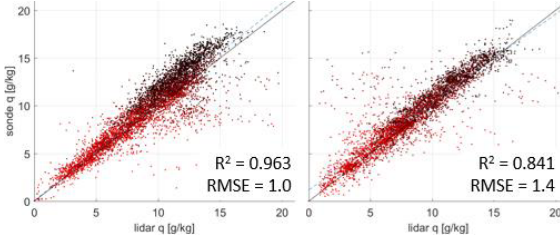
Figure 1. Comparison of water vapor mixing ratio (g/kg) from sonde and lidar at FP1 (left) and FP3 (right), with dashed line of best fit and solid 1-to-1 line. Color indicates measurement height, fading black to red from 0 km to 3